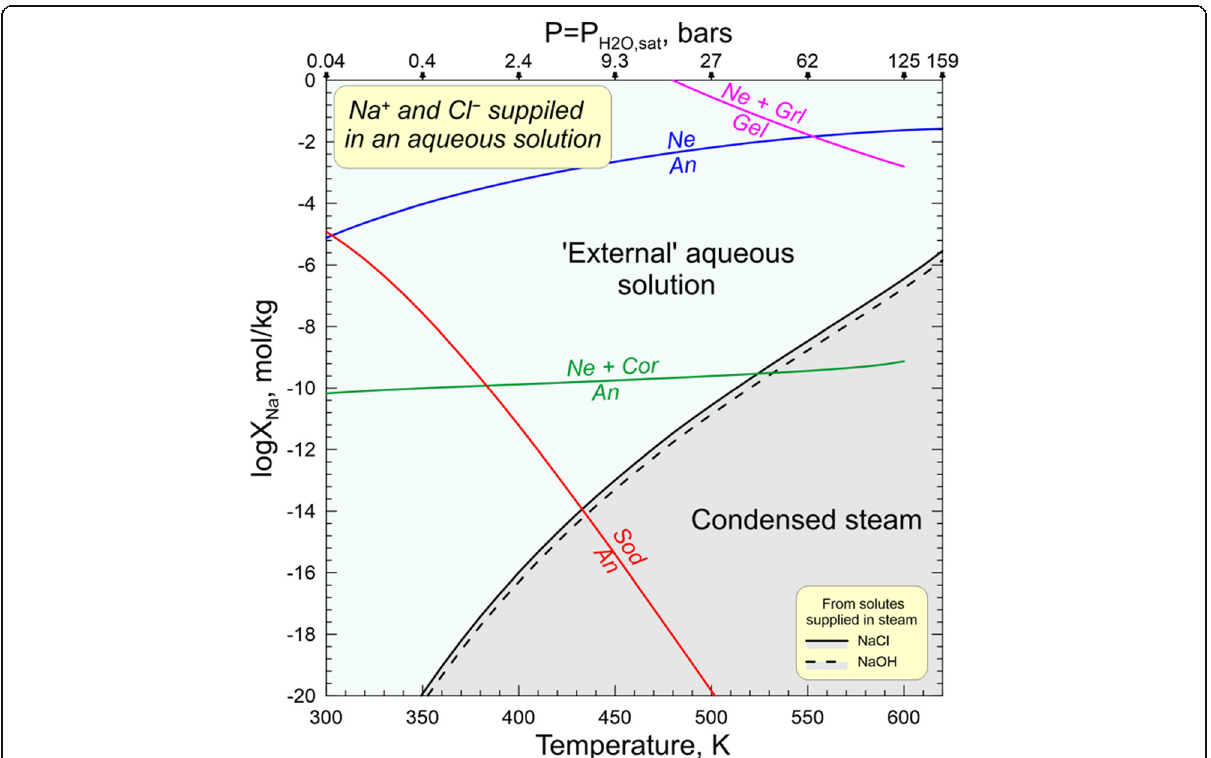
Fig. 19 Phase boundaries of reactions R19, R20, R31 and R32 involving addition of Na + and removal of Ca 2+ at the X CO2 defined by R28, lowest X Ca2+ defined by R4 (melilite-anorthite equilibrium – top left panel of Fig. 20). The activity of aqueous SiO 2 in reactions R31 and R32 is set at the upper limit of X SiO2 defined by R27. The “ condensed steam ” field designates an aqueous solution formed by in situ condensation of steam as opposed to the “ external ” aqueous solution, which comes to a CAI from outside (matrix?) as a